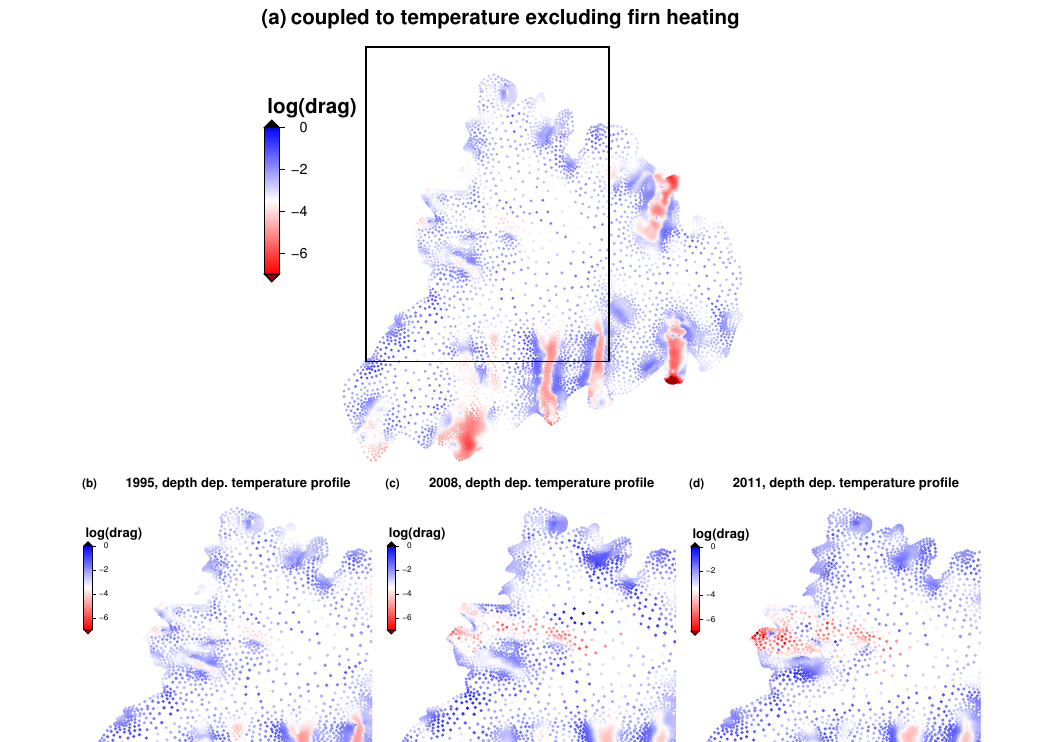
Figure 2. Distribution of the basal friction parameter in 1995 when coupling to temperature: (a) simulation beta95T . The other three figures show a close-up over Franklinbreen (using the depth-dependent temperature profile) in 1995 (b) , 2008 (c) and 2011 (d) (simulations beta95, beta08, beta11 ). Note that only the southwestern corner has been patched with 1995 data in the 2008 and 2011 data sets. All figures are in logarithmic scale (units are MPayrm − 1